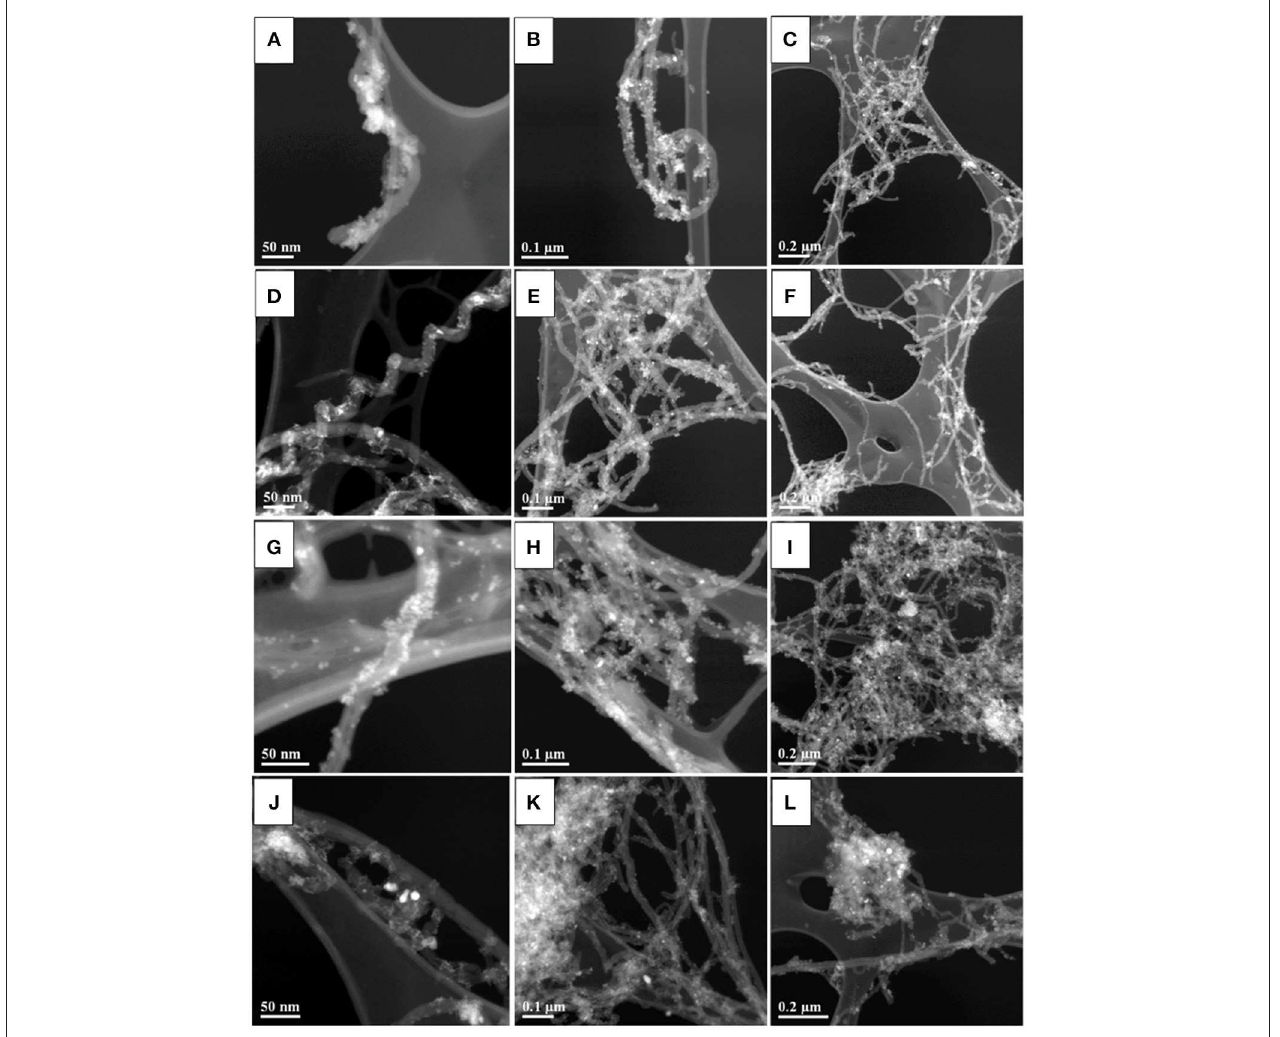
FIGURE 3 | TEM images at different magnifications for (A–C) M-CB-MWCNT, (D–F) M-PV-MWCNT, (G–I) M-AA-MWCNT, and (J–L) M-CP-MWCNT.